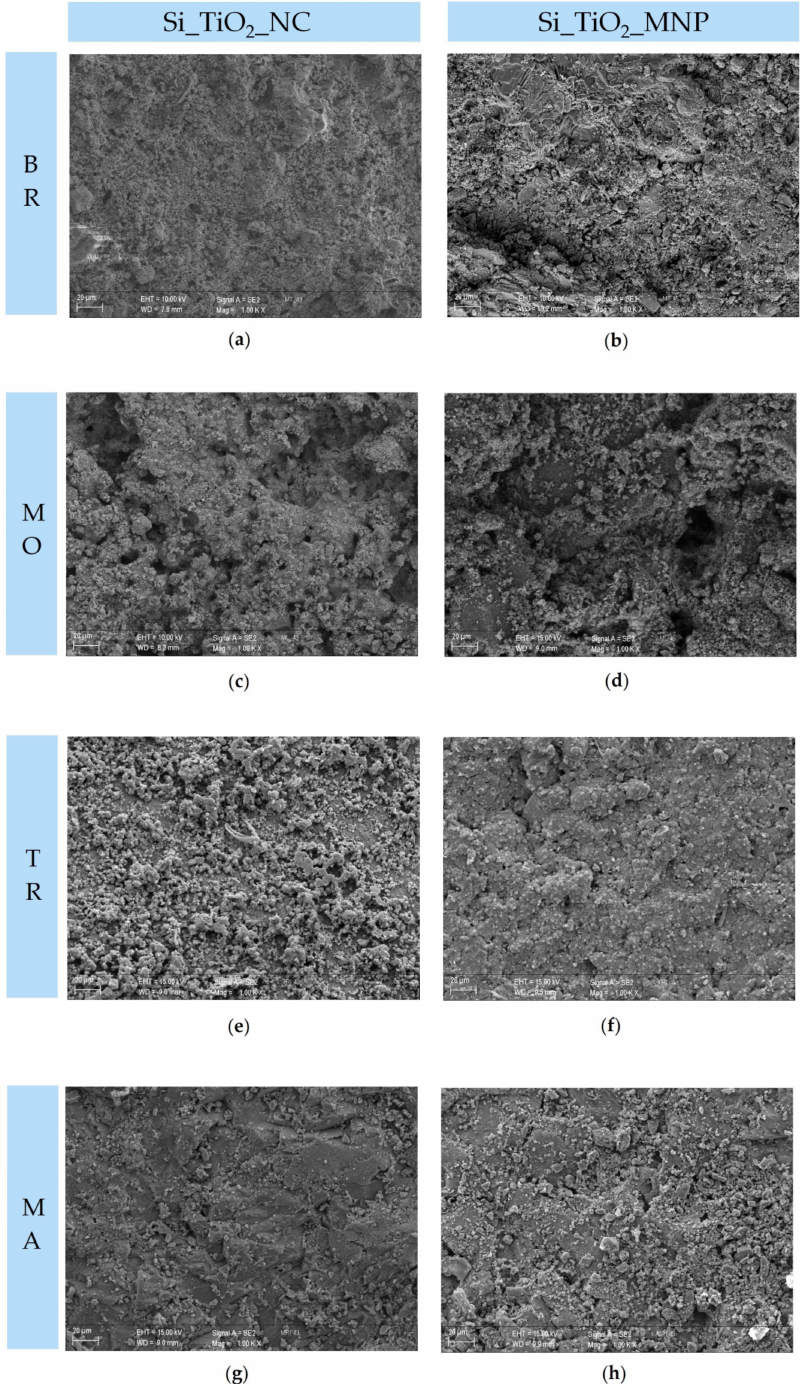
Figure 5. SEM images (1000 × ) of coated stones treated with Si-TiO 2 -NC and Si-TiO 2 -MNP: ( a , b ) brick (BR), ( c , d ), mortar (MO), ( e , f ) travertine (TR) and ( g , h ) Carrara marble (MA). Aiming at evaluating the photocatalytic property of the TiO 2 dispersed in the coating formulation, the degradation of methyl orange over time was examined under laboratory conditions. The discoloration of stones was reported as ∆ E * variation (Figure 6). In the case of brick, the color of the used stained compound was very similar to that of substrate. For this reason, the color differences among the consecutive measurements had larger uncertainties compared to those performed on the other